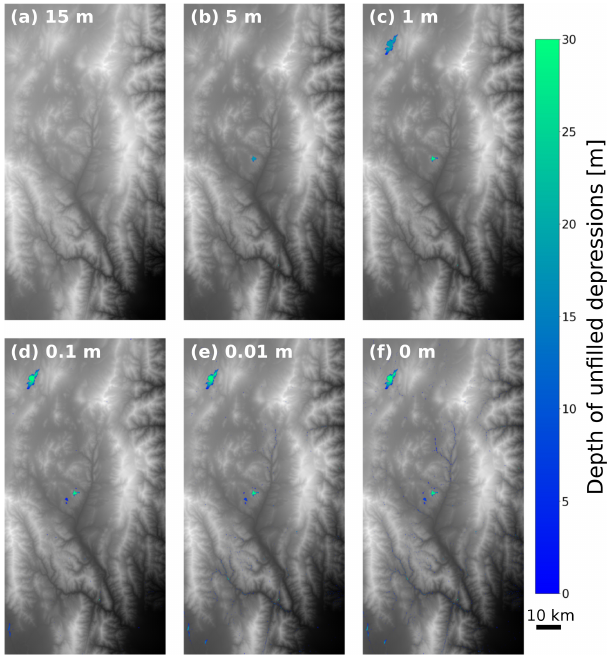
Figure 7. Depths of unfilled depressions in the Río Toro study area with starting runoff depths of (a) 15m, (b) 5m, (c) 1m, (d) 0.1m, (e) 0.01m, and (f) 0m (i.e. the input DEM with no changes made). DEM elevations are shown in greyscale, from dark (low) to light (high), while blue and green indicate the locations of depressions still present in the flow-routing surface. (a) In the case in which 15m of runoff was used, all depressions in the DEM were filled. (b) With 5m of runoff, we see a persistent depression near the centre of the study region. (c) Another large depression appears with 1m of runoff, but most smaller depressions are filled. (d, e) With 0.1m runoff and less, more depressions appear in the landscape. (f) All of the depressions appear on the original, unfilled